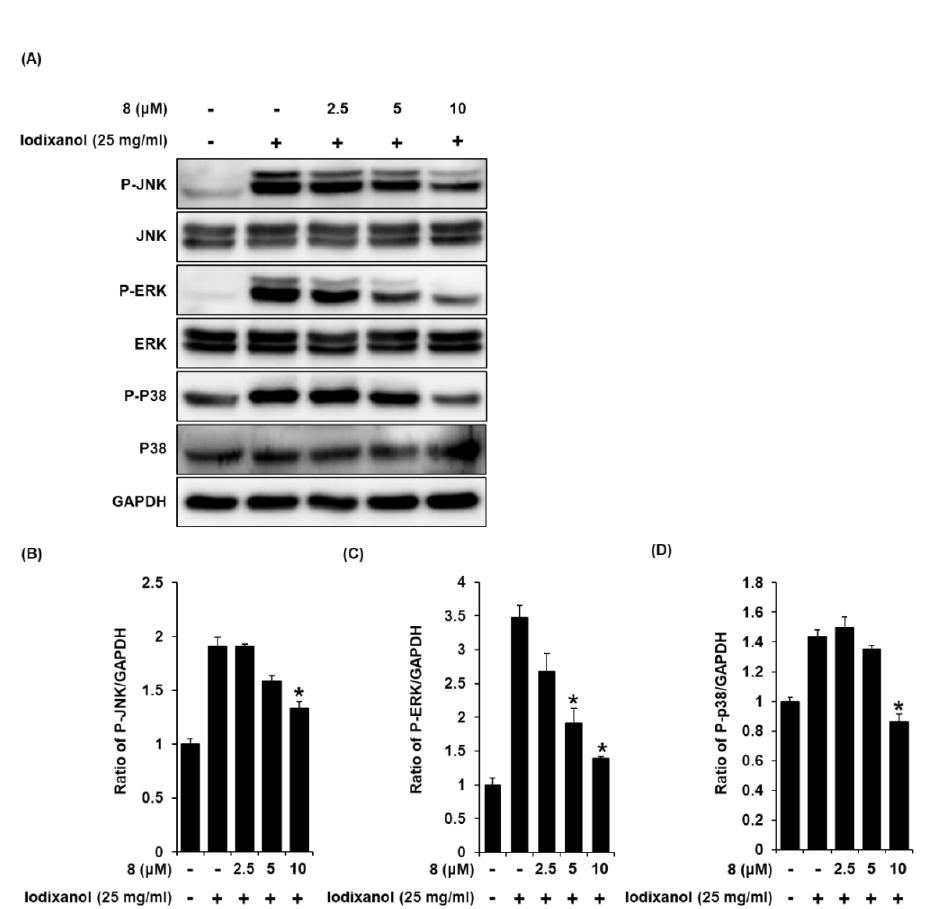
Figure 9. The effects of 3- epi- iso -seco -tanapartholide (compound 8 ) on the expression of JNK, ERK, p38 proteins associated with MAPK pathways in LLC-PK1 cells treated with iodixanol. ( A ) LLC-PK1 cells were treated with 25 mg/mL iodixanol in the absence or presence of compound 8, and western blot analysis was performed using antibodies for P-JNK, JNK, P-ERK, ERK, P-P38, P38, and GAPDH. ( B – D ) The ratios of JNK, ERK, and P38 phosphorylation compared with untreated cells are represented as a bar graph (mean ± SD, n = 3, * p < 0.05 compared with iodixanol-treated LLC-PK1 cells).